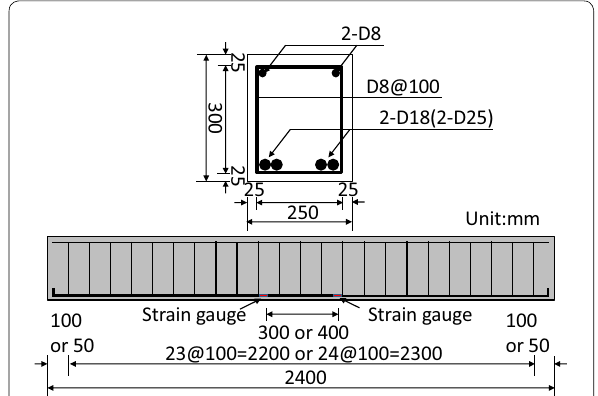
Fig. 1 Details of test specimens (mm, 1 mm